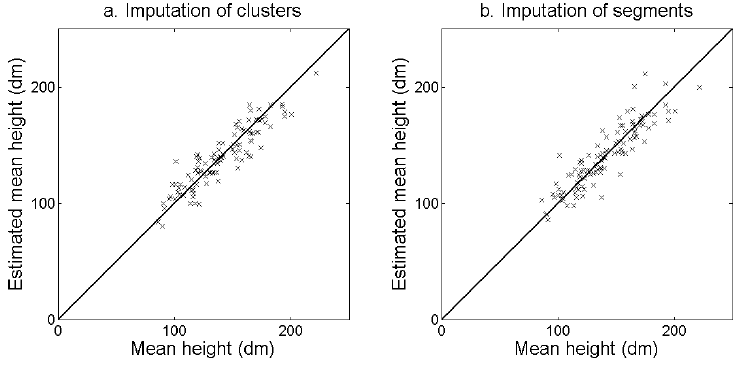
Figure 11. Basal area-weighted mean height at plot level estimated from ( a ) imputation of clusters with model Cluster1 and ( b ) imputation of segments with model Segment1.